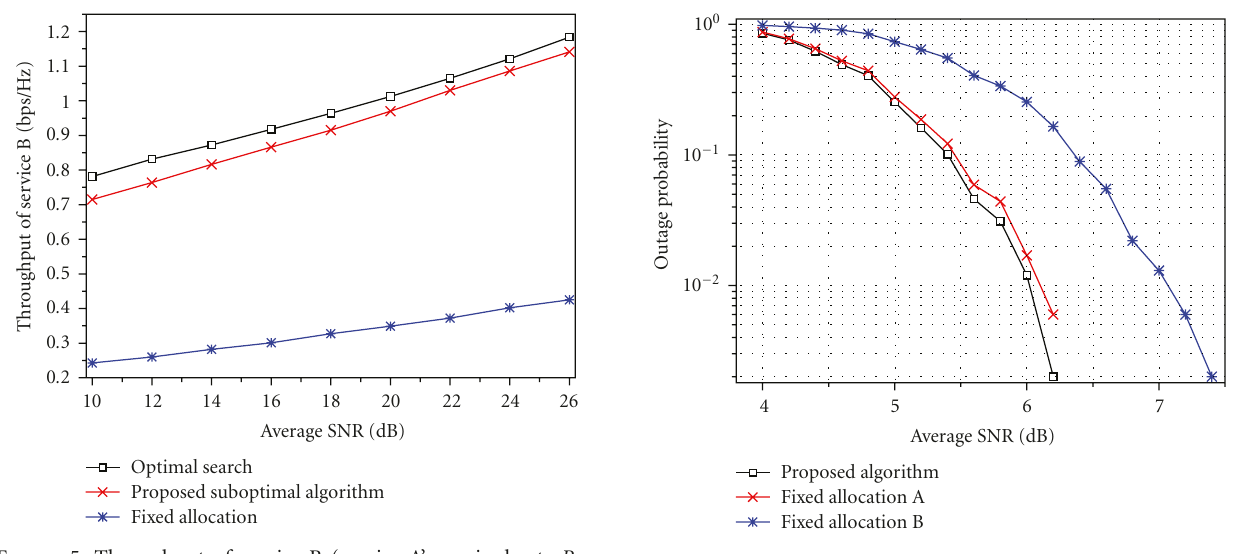
Figure 7: Outage probability of service A (RT) users.